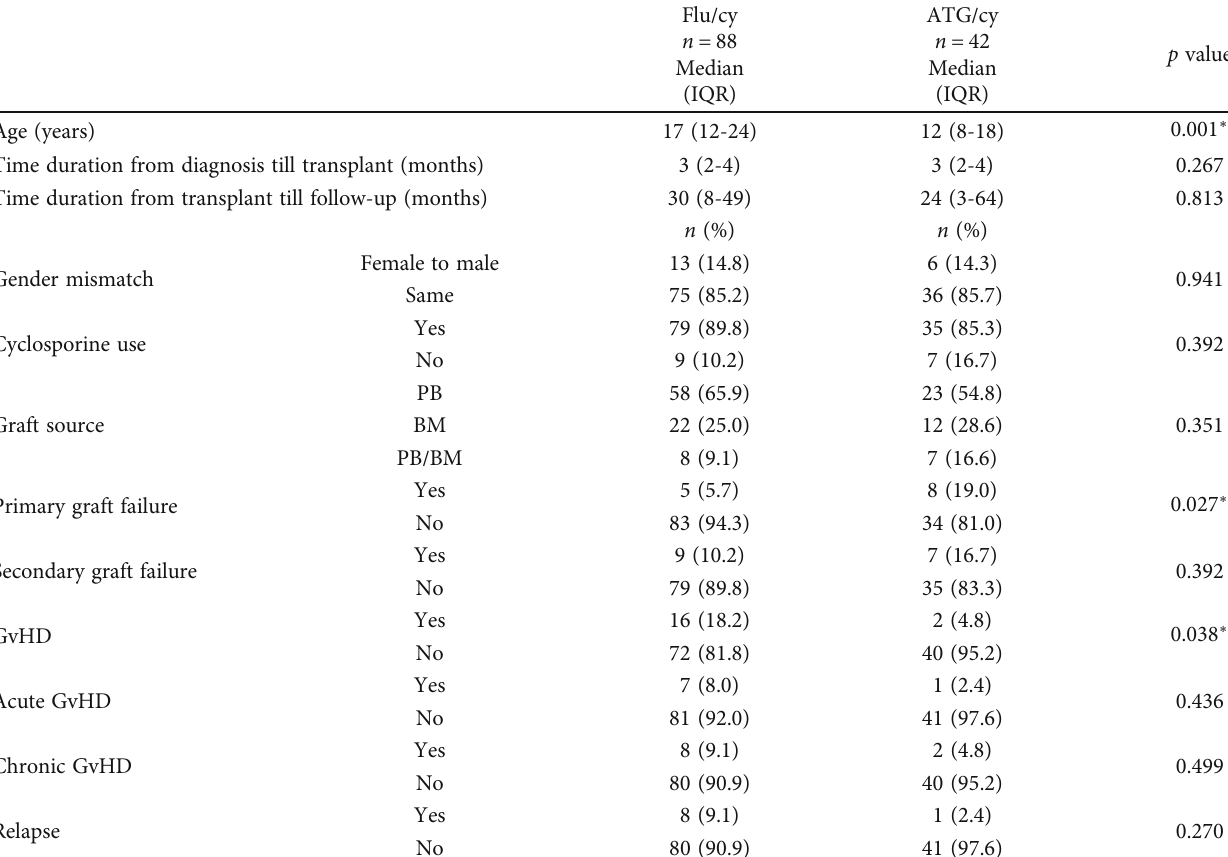
Table 2: Distribution of Flu/Cy verses ATG/Cy with transplant characteristics ( n = 130